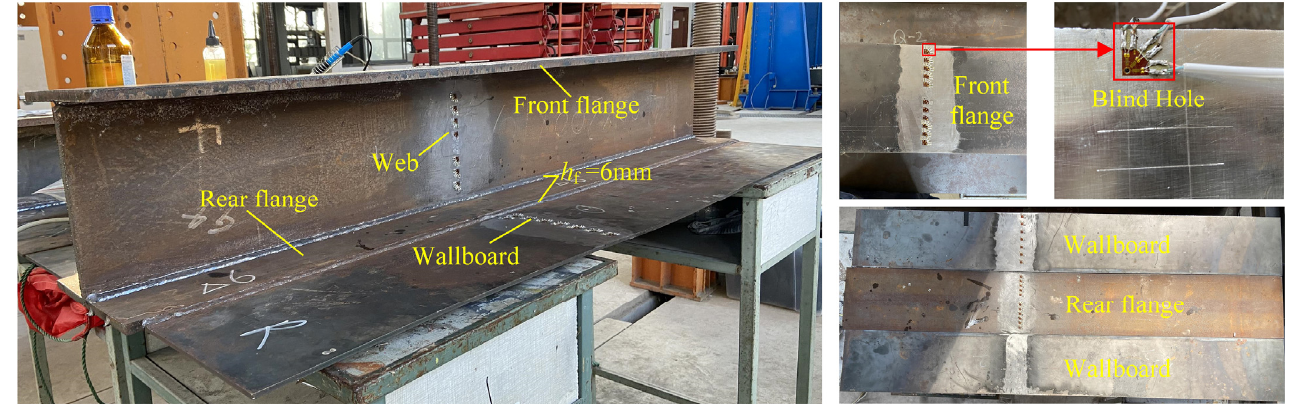
Figure 8. Welding residual stress measuring test setup of the hole-drilling method. Table 4. Material mechanical properties and welding